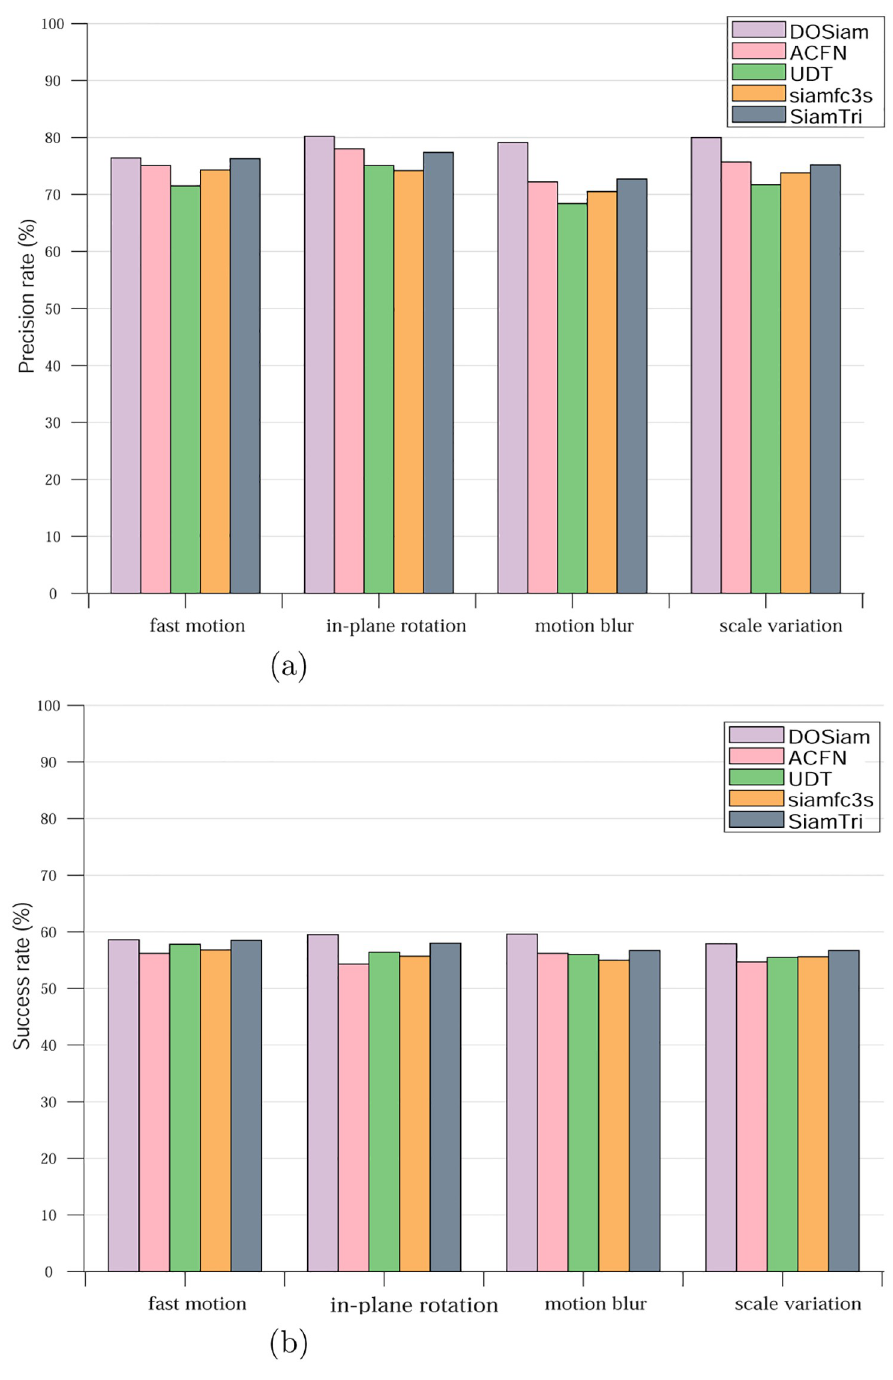
Fig 8. A comparison of the DOSiam with state-of-the-art trackers of precision and success rate in terms of fast motion, in-plane rotation, motion blur and scale variation.